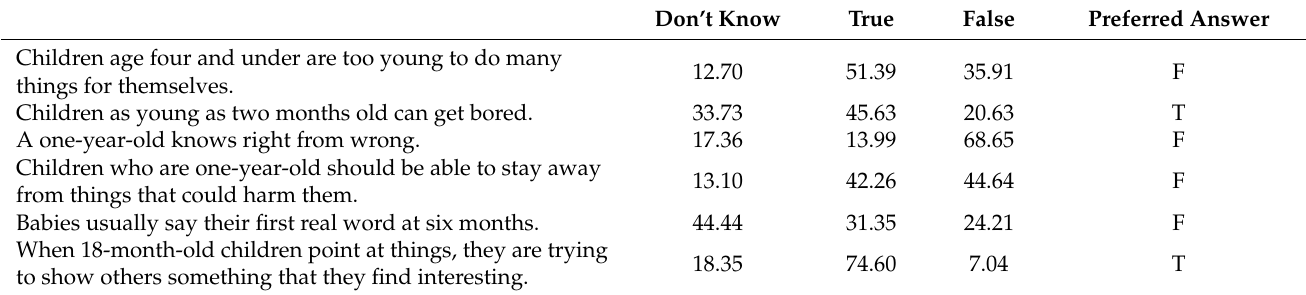
Table 4. Percentage of participants’ responses to questions about their knowledge of child development. Don’t Know True False Preferred